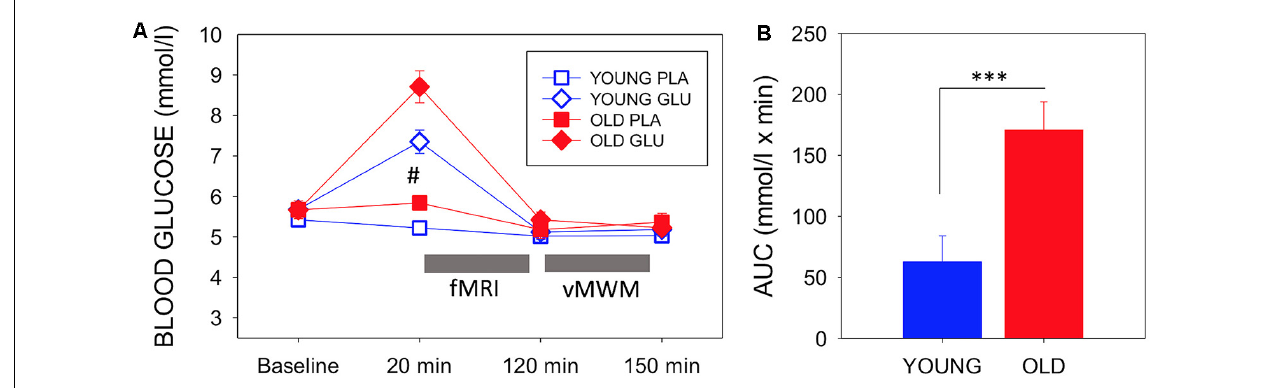
FIGURE 3 | (A) Mean (with SEM) blood glucose levels at baseline, pre-magnetic resonance imaging (MRI) (20 min post-dose), post-MRI (120 min post-dose), and end of testing (150 min post-dose) for each group and each visit. Circles depict younger adults, while squares depict older adults. Filled symbols represent measures taken on glucose visit, while open symbols represent measures at the placebo visit. # Indicates a significant difference between drink condition and significant difference between ages in both drink conditions ( p -values see text). Timing of fMRI and virtual Morris Water maze (vMWM) are indicated in relation to glucose measurements. (B) Blood glucose incremental area under the curve as a measure of glucoregulatory efficiency, bars depict mean (with SEM). Older adults had significantly higher incremental area under the curve (iAUC) than younger adults ( T (1,28) = − 3.403, P = 0.002), indicating poorer glucose regulation. ∗∗∗ P < 0.005.